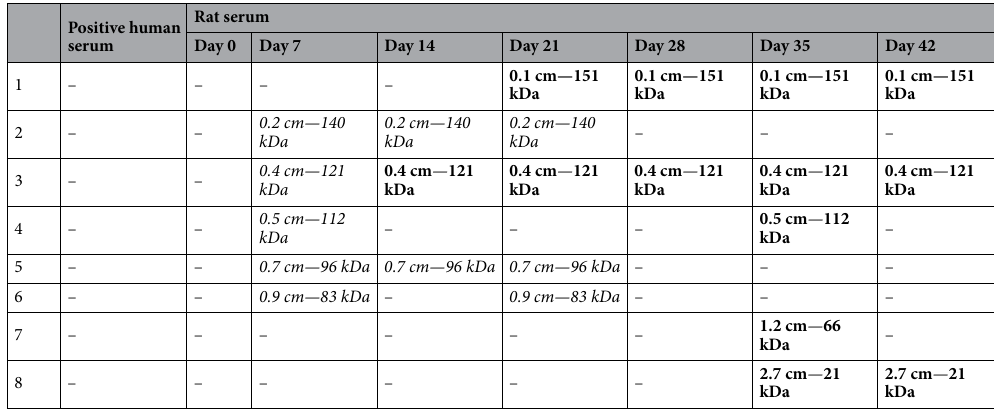
Table 3. Distances traveled and the estimated molecular weights of the immunogenic E. vermicularis egg antigens. IgM: italics, IgG: